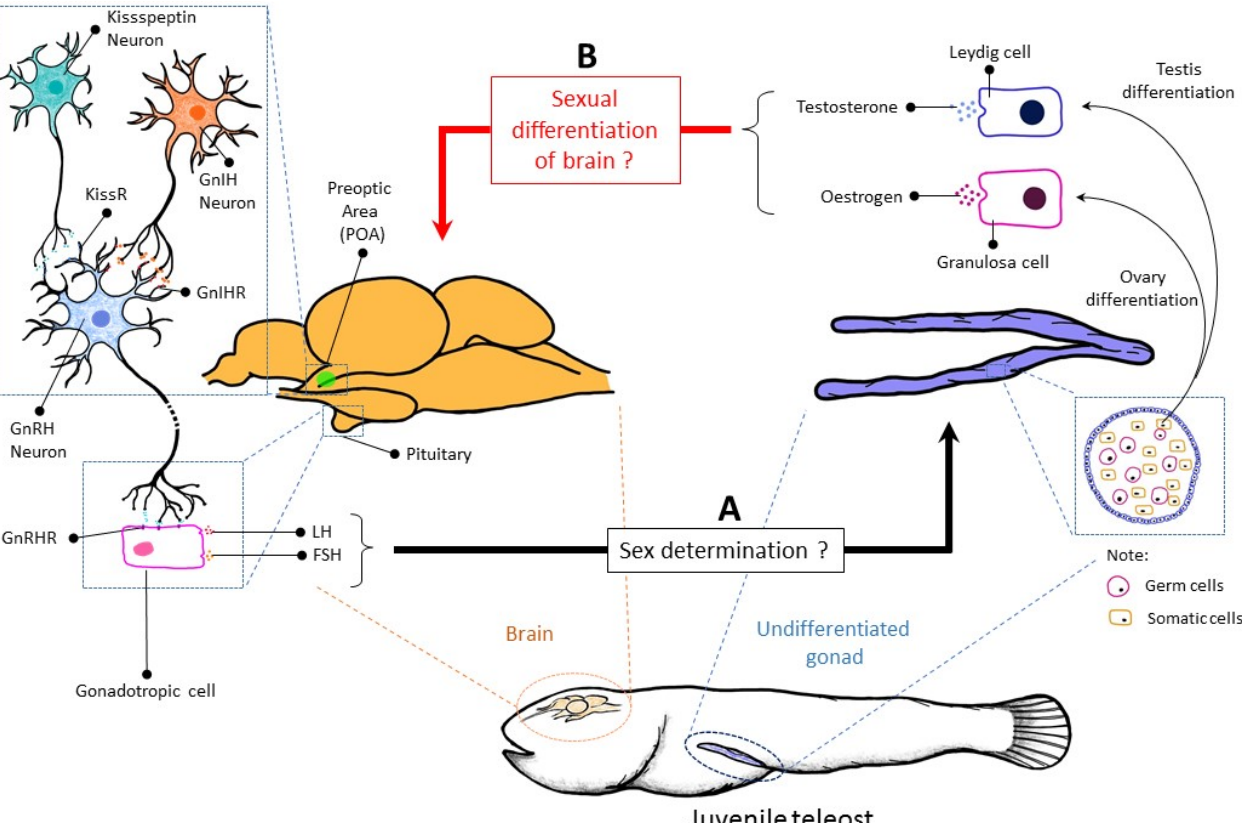
Figure 2. The schematic diagram of the uncertain pathway in the gonadal sex determination and sexual differentiation of the brain. ( A ) The role of the brain during sex determination remains elusive. There is only one study in zebrafish that shows that GnRH III knockout has resulted in a male sex-biased population. To date, there is no evidence showing LH and FSH directly regulate the expression of sex-determining genes ( amhr2 , amhy , dmrt1 , dmy , gdf6Y , gsdf , and sdY ). ( B ) The role of testosterone (T) and oestrogen involved in masculinisation and feminisation in a fish, respectively. Nonetheless, whether the gonads initially differentiated into testes or ovaries followed by sexual differentiation of the brain, or vice versa, is